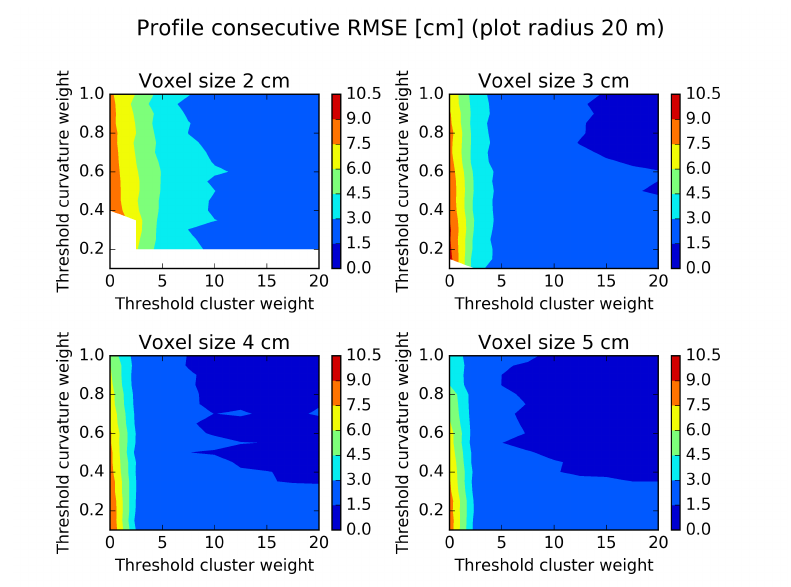
Figure 11. Profile consecutive diameter RMSE evaluated on a plot of a radius of 20 m and different parameter settings. White areas indicate missing data. High parameter threshold values give smooth stem